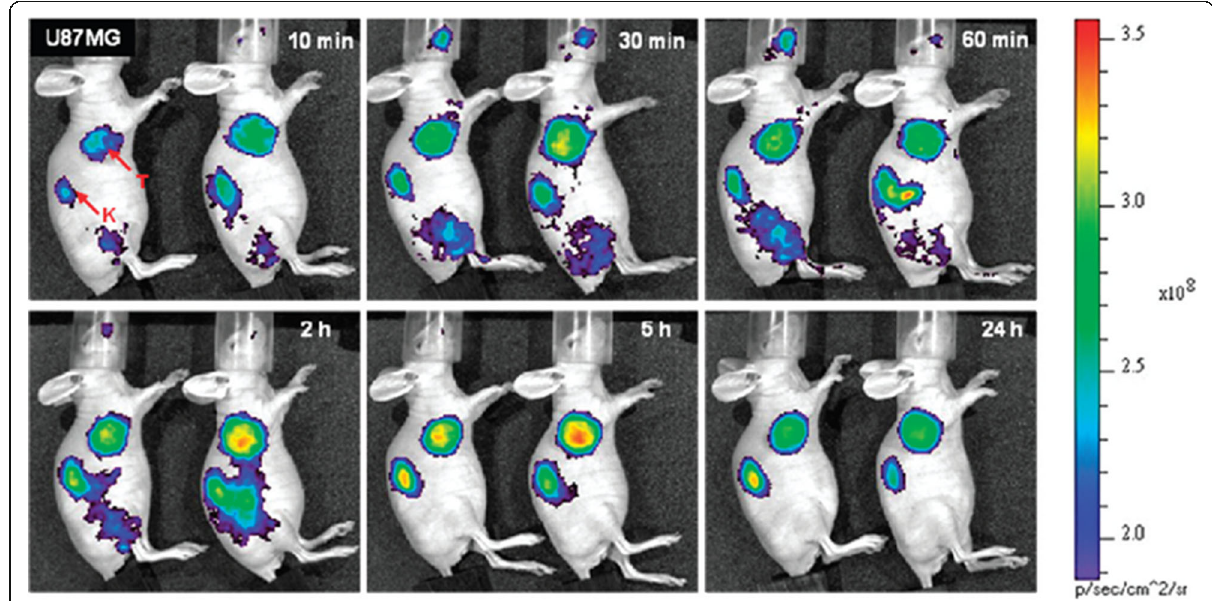
Fig. 3 In vivo fluorescence imaging of U87-MG bearing xenografts after iv injection of cMBP-GGG-Cy5.5 ( left ) or cMBP-AOC-Cy5.5 ( right ), of which red arrows indicate the tumor (T) or kidney (K). With permission from reference